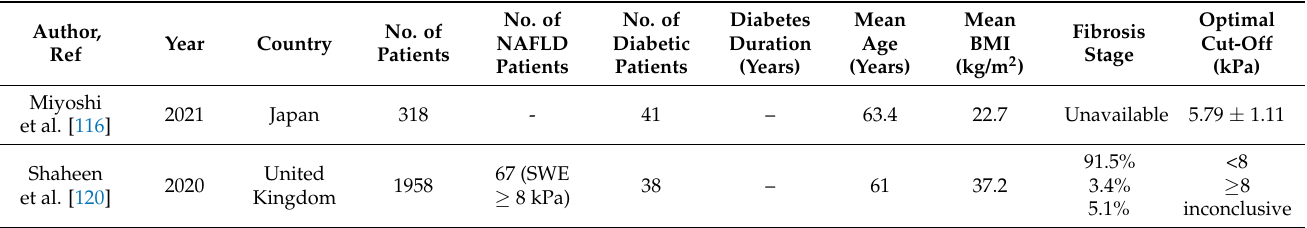
Table 3. Diagnostic performance and comparison of results for different fibrosis stages using 2D-SWE in patients with NAFLD and